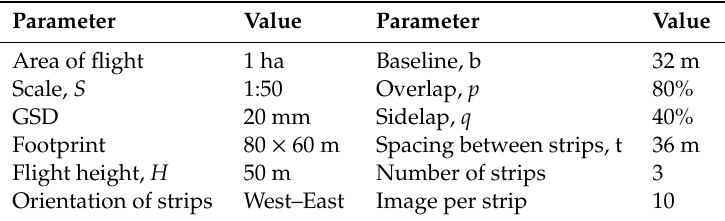
Table 1. Specifications of unmanned aerial vehicle (UAV) flight planning.